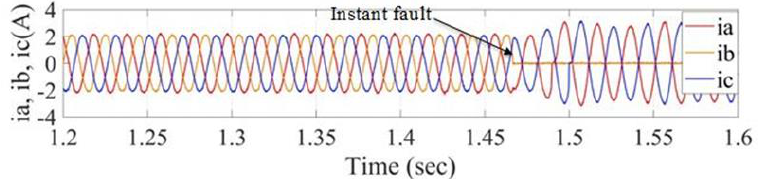
Figure 24. Stator current signal for no-load and when the phase (b) has been disconnected/lost.